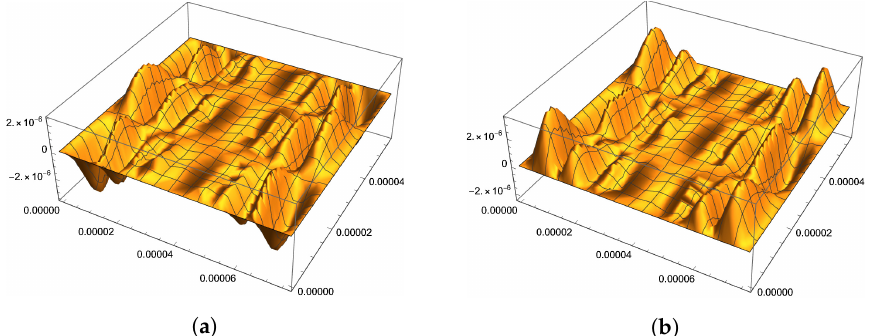
Figure 12. Recovery of loads when there is no regularization. ( a ) Recovery of f 1 when there is no regularization. ( b ) Recovery of f 2 when there is no regularization.